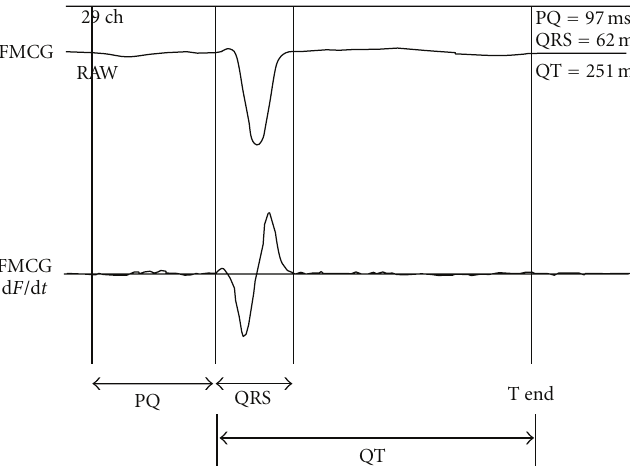
Figure 3: Determination of PQ, QRS, and QT intervals by di ff erentiation. In performing FMCG, a total of 300–500 heartbeats detected per determination were summated to yield the mean. The initial and termination points of the PQ, QRS, and T wave were defined by the first derivate of d F/ d t